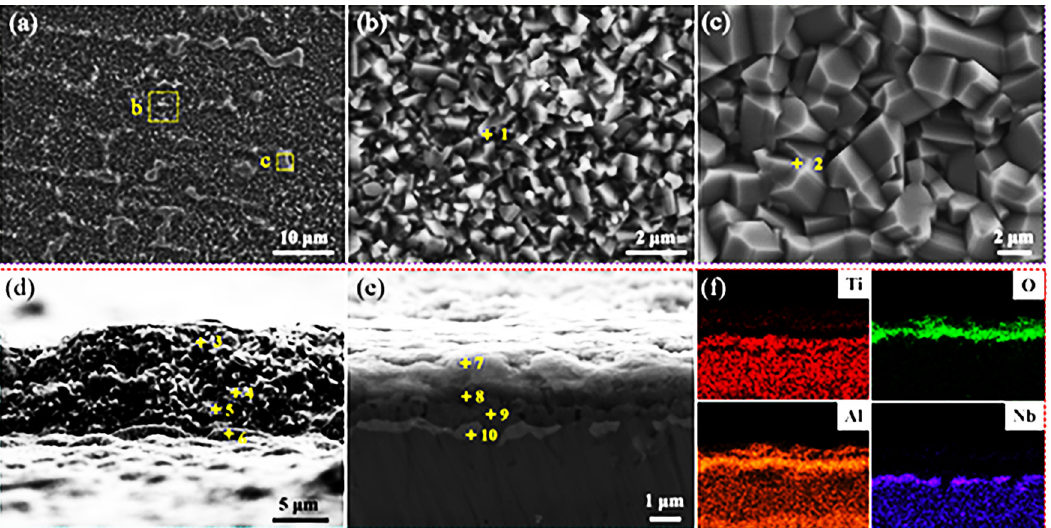
Figure 6. ( a ) Surface morphology of the fluorine ‐ treated specimen after oxidation at 1000 °C for 100 h, ( b , c ) the local regions at high magnification, ( d ) SEM side ‐ view of the oxide scale top layer, and ( e ) the cross ‐ section morphology and ( f ) its EDS mapping results.